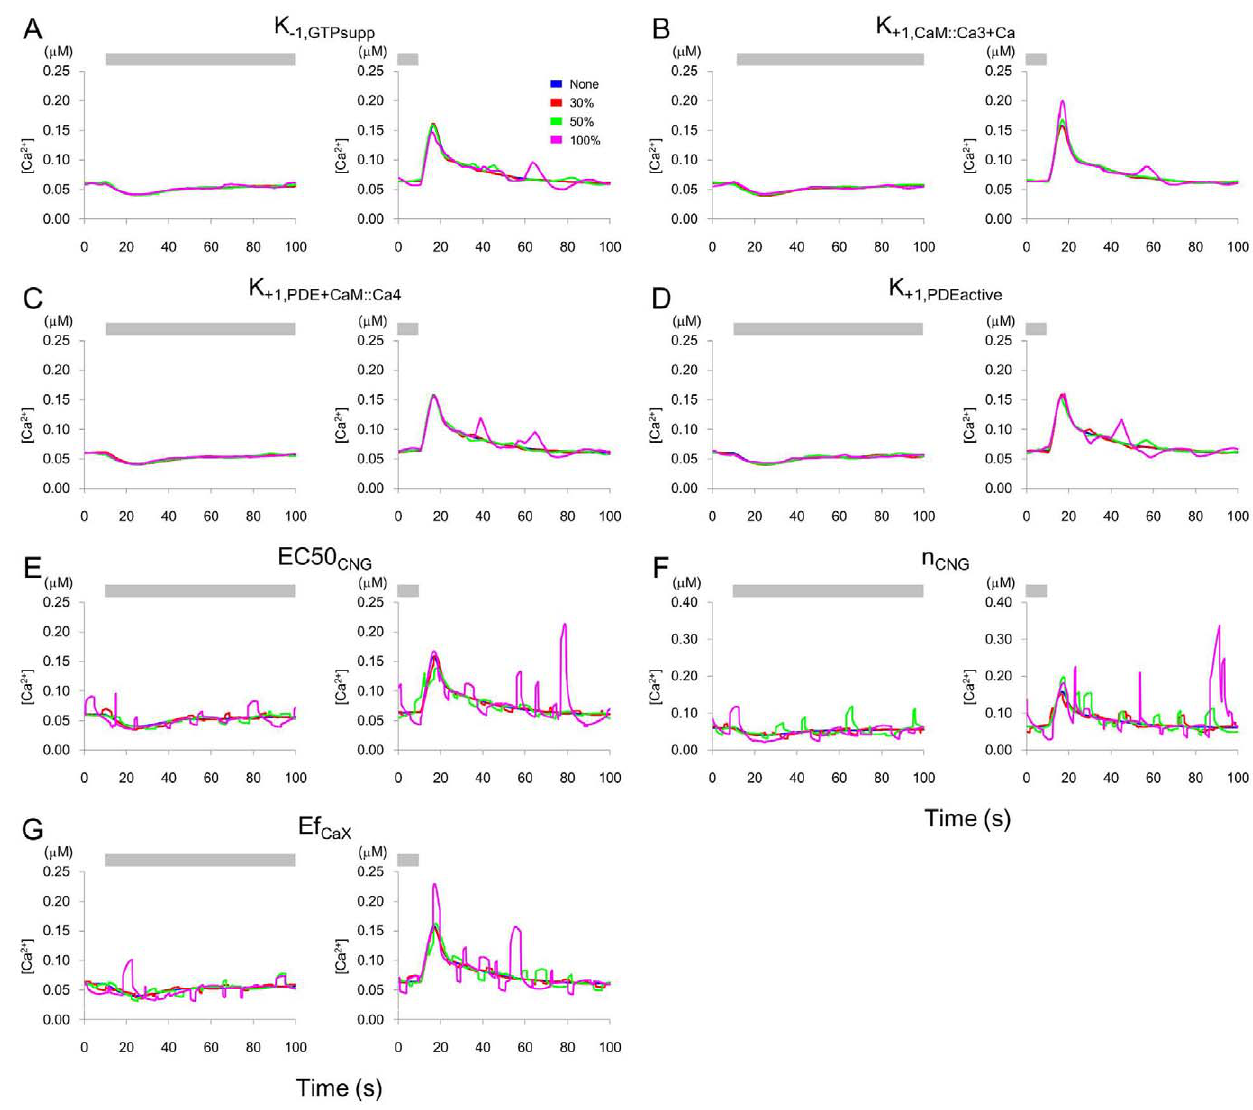
Figure 5. Changes in [Ca 2 + ] by fluctuation of the equation parameters. Changes in [Ca 2 + ] when the equation parameters (indicated in each panel) include a random pulse train as described in Methods. The fluctuation of EC50 CNG , n CNG and Ef CaX produced large changes in [Ca 2 + ]. Odor stimulus was given for 5 min and was removed at 10 s (right panel). The bar indicates the stimulus. Blue: no addition of fluctuation. Red, green, and magenta lines represent 30, 50, 100% magnitudes of the maximum pulse height of the noise,